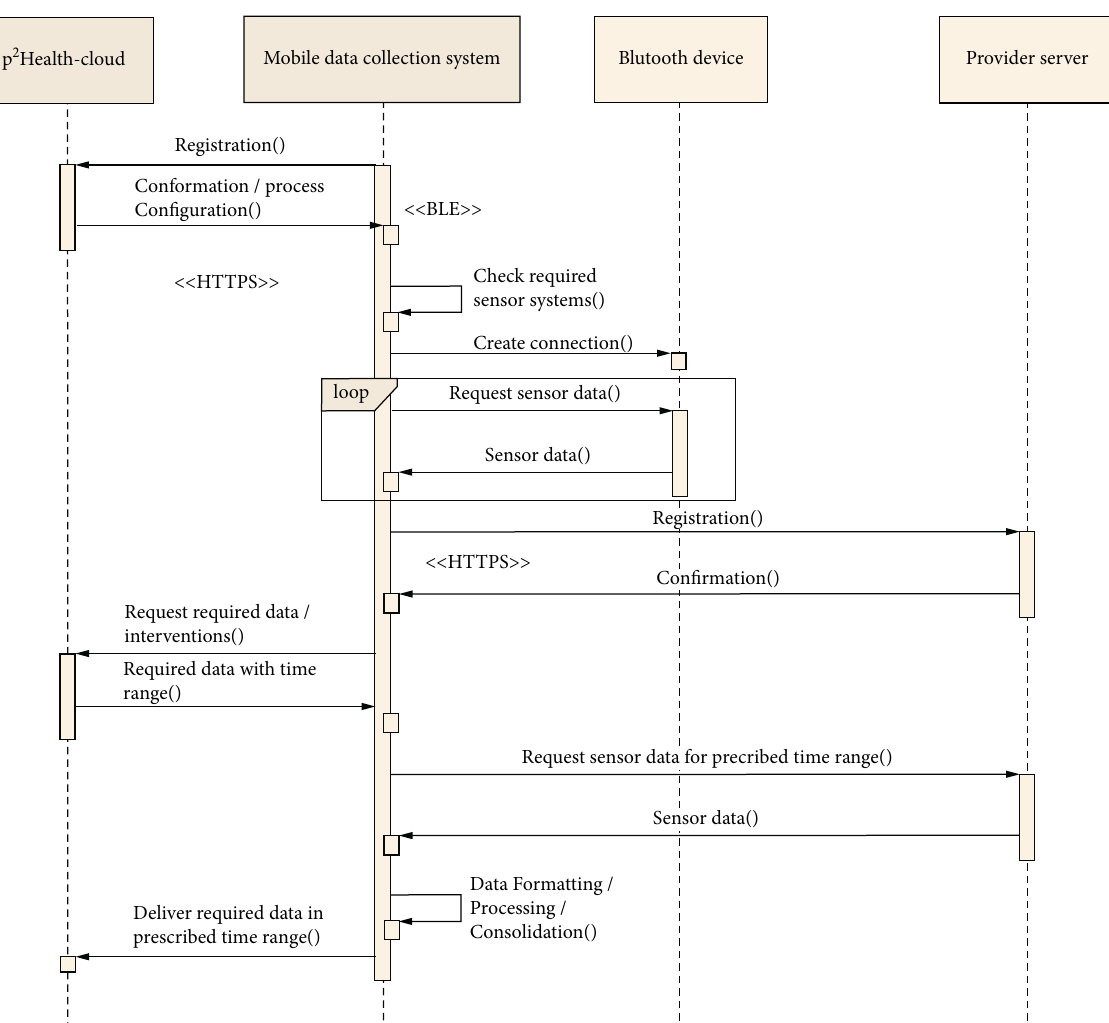
Figure 4: Simplified sequence diagram with the initialization procedure of the connections (between the mDCS, the p 2 Health-Cloud, and the sensor solutions) and the control of the sensor data